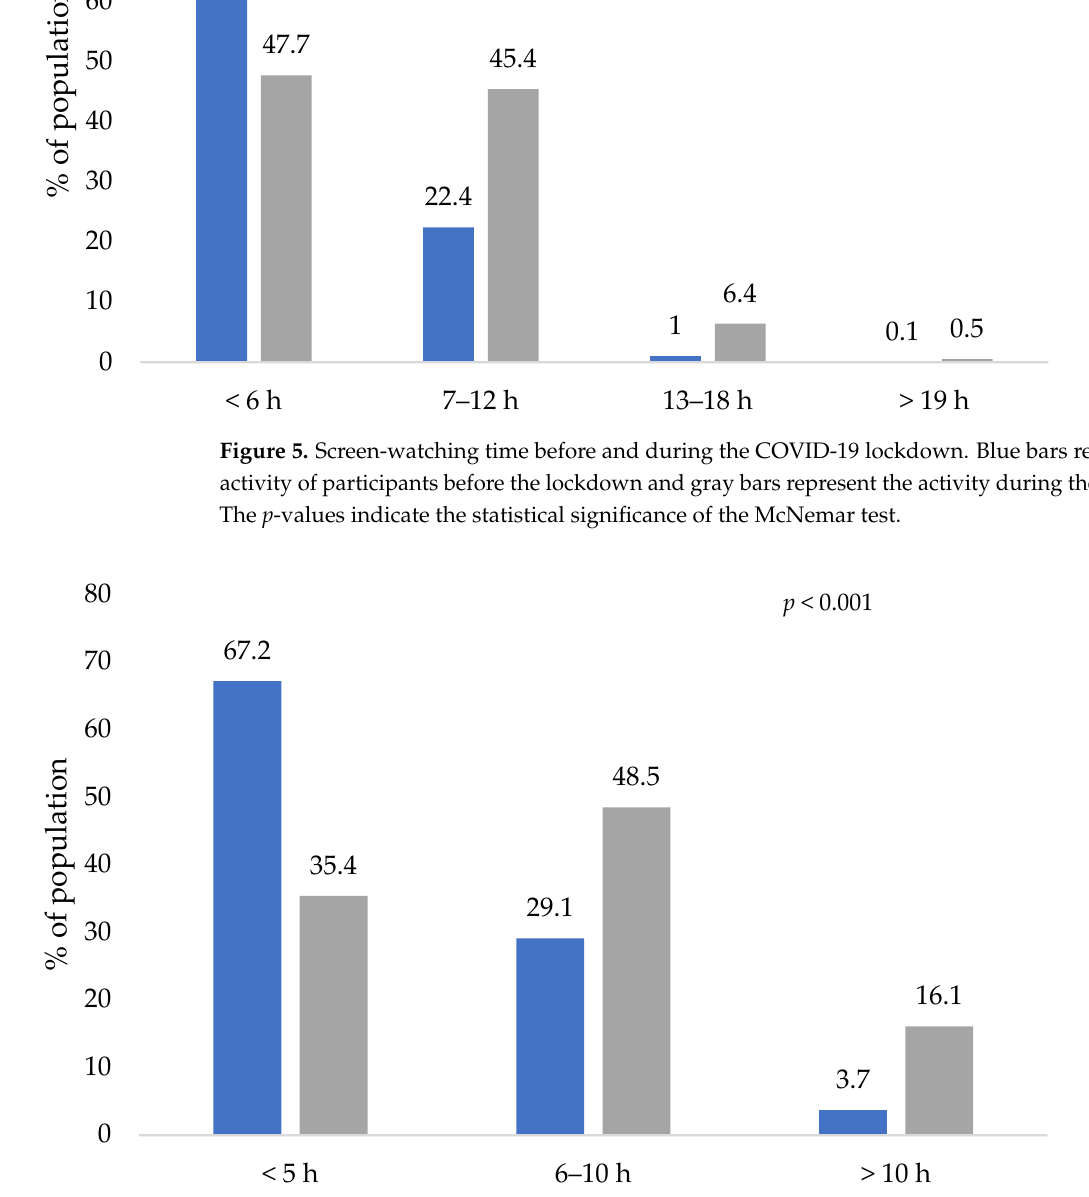
activity of participants before the lockdown and gray bars represent the activity during the lock-